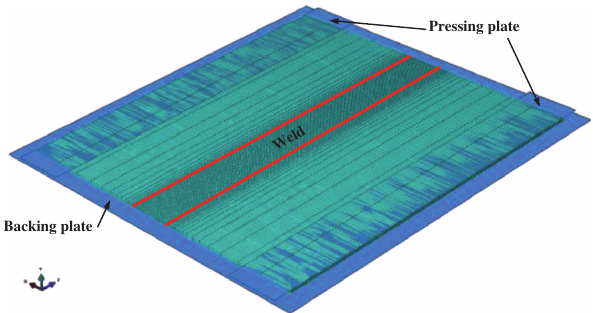
Figure 3: Mesh distribution used in